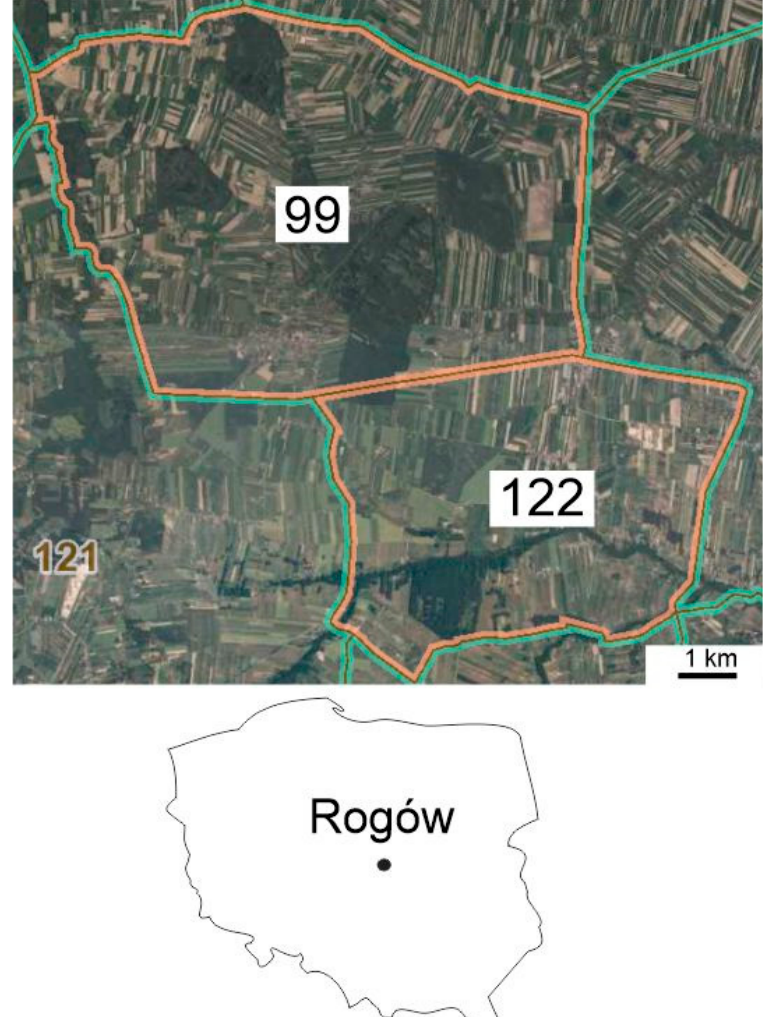
Figure 1. The study area located in Central Poland (black dot). The study was conducted in the areas of the hunting units no 99 and 122. Their borders are marked in orange. Source of the maps: [44].